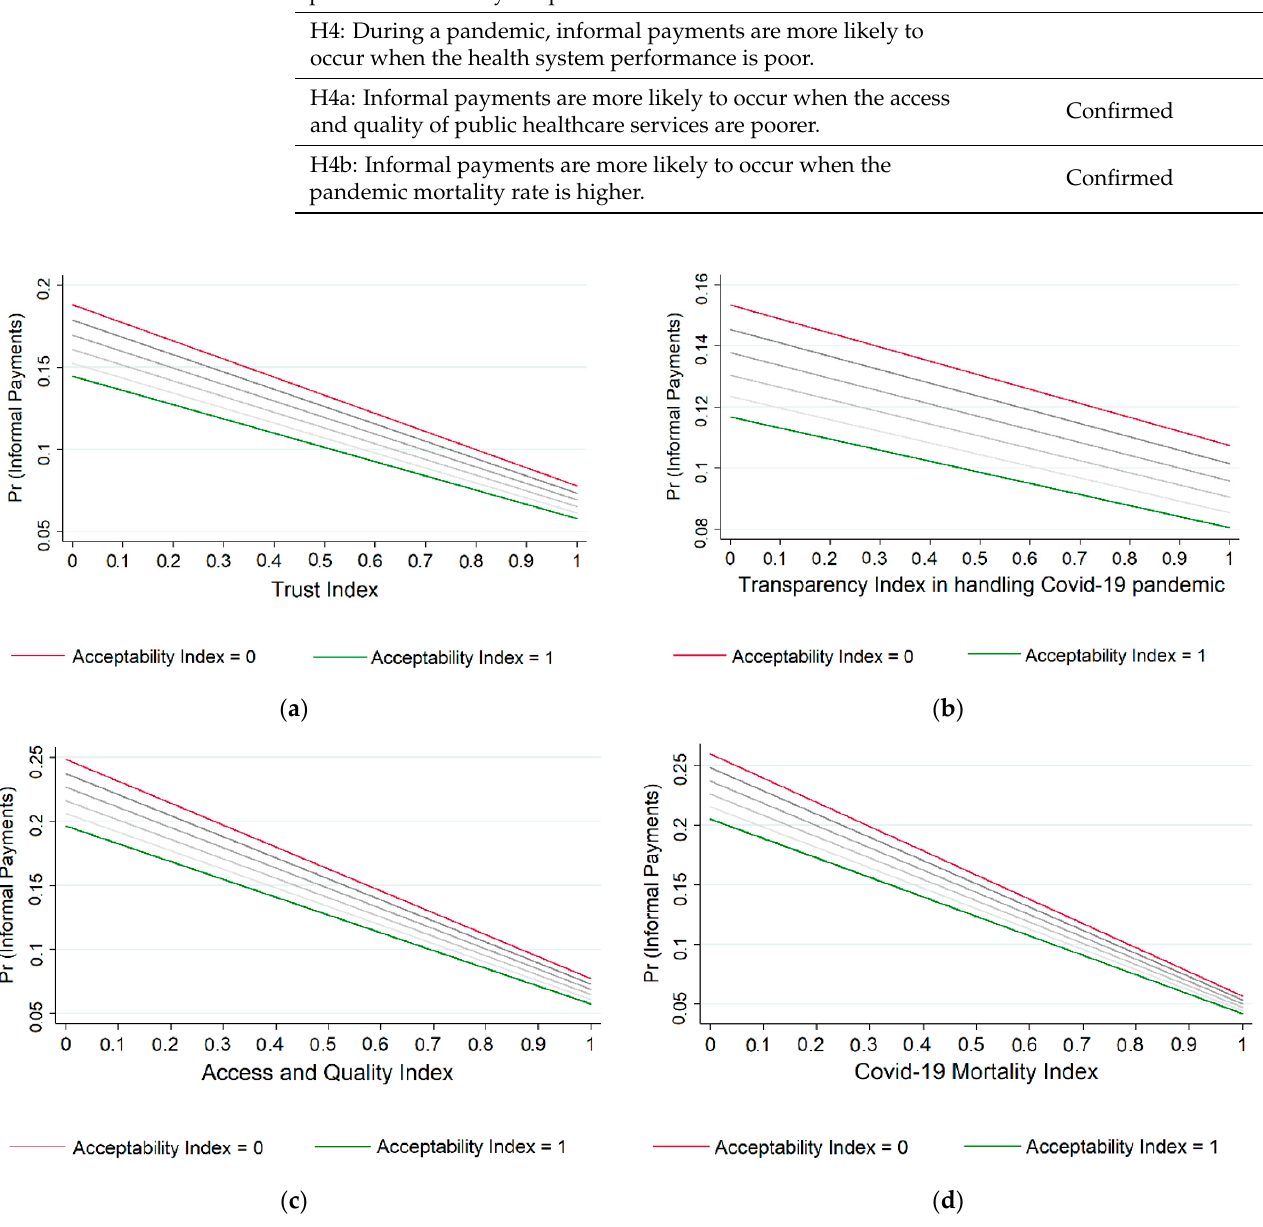
Figure 1. Predicted probability to make informal payments by a ‘representative’ patient in Central and Eastern Europe, by Acceptability of Corruption Index and: ( a ) Trust Index (trust in authorities); ( b ) Transparency Index (transparency in handling COVID-19 pandemic); ( c ) Access and Quality Index (health system performance: access and quality); ( d ) COVID-19 Mortality Index (health system performance: COVID-19 deaths/100,000 inhabitants). Notes: After logistic regression. The ‘representative’ patient in Central and Eastern Europe was obtained by taking the mean and mode of the socio-demographic characteristics as displayed in Table A1, namely: female, 49 years old, primary or secondary educated, working full time, having enough money to buy what is needed and living in a large town. Source: author’s calculations using data from [6,42,43].